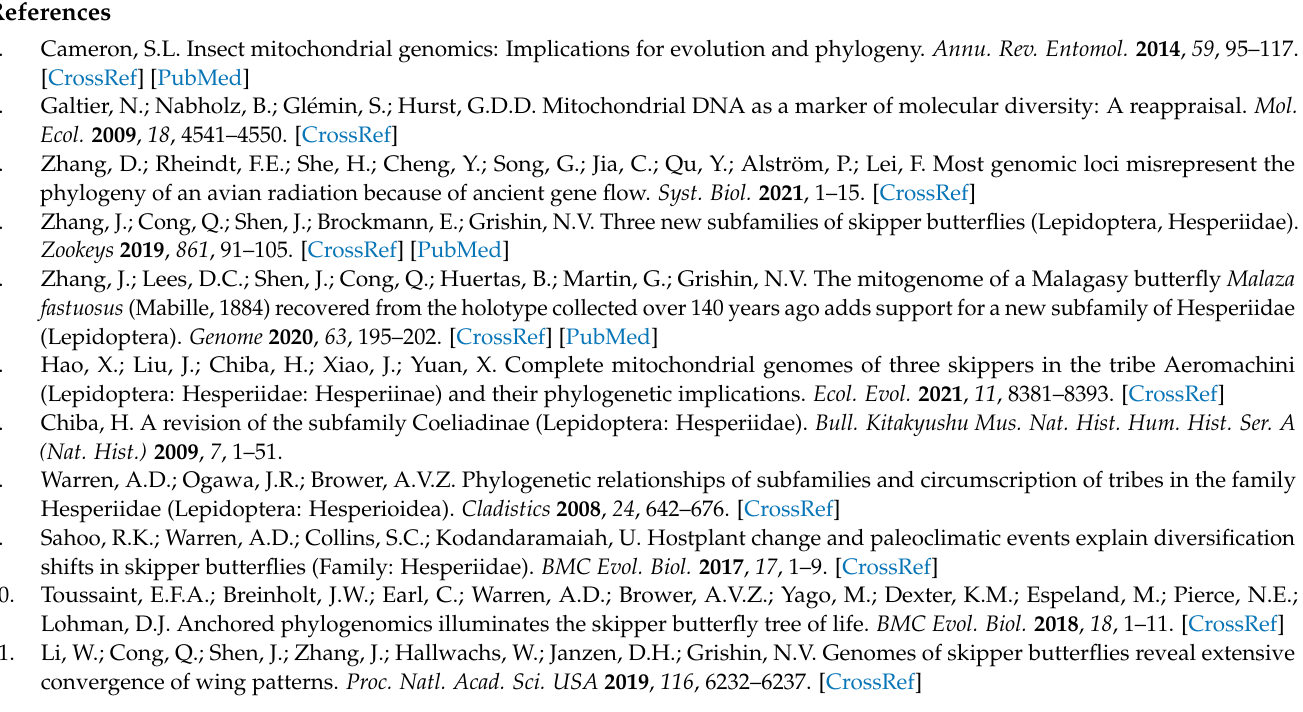
Figure S3: Phylogenetic tree inferred by ML method based on 12PRT dataset. Numbers on nodes are the bootstrap support values (BS), Figure S4: Phylogenetic tree inferred by BI method based on PCG dataset. Numbers on nodes are the posterior probabilities (PP), Figure S5: Phylogenetic tree inferred by BI method based on 12PRT dataset. Numbers on nodes are the posterior probabilities (PP), Figure S6: Predicted secondary cloverleaf structure of tRNA of H. schoenherr , Figure S7: Predicted secondary cloverleaf structure of tRNA of B. miracula , Figure S8: Predicted secondary cloverleaf structure of tRNA of B. oedipodea , Figure S9: Predicted secondary cloverleaf structure of tRNA of B. harisa , Figure S10: Predicted secondary cloverleaf structure of tRNA of B. exclamationis , Table S1: Nucleotide composition and skewness of different elements of mitogenomes of H. schoenherr , B. mirac- ula , B. oedipodea , B. harisa and B. exclamationis , Table S2: Mitogenomic organization of H. schoenherr , B. miracula , B. oedipodea , B. harisa and B. exclamationis , Table S3: Best partitioning schemes and models based on different datasets for BI analysis, Table S4: Best partitioning schemes and models based on different datasets for ML